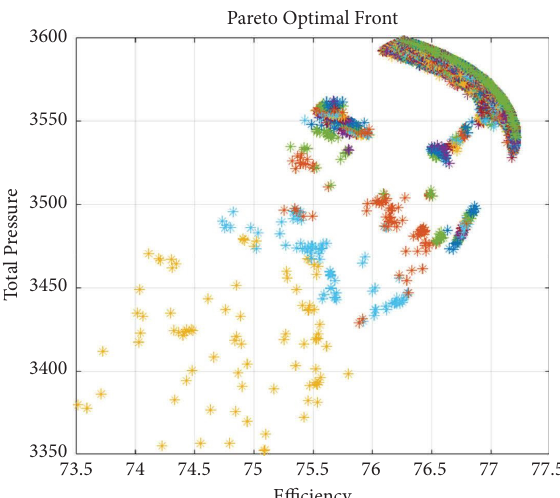
Figure 10: Te distribution of nondominated solution